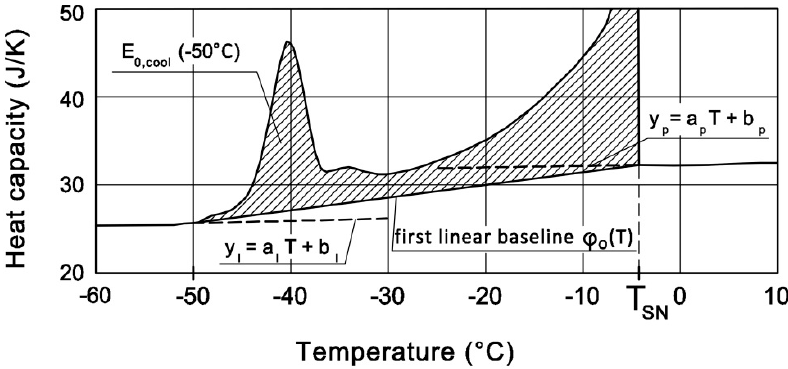
Figure A2. Heat capacity plot with marked lines y p , y l and φ 0 (T).